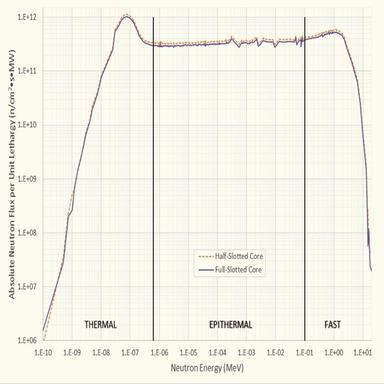
Comparison of Peak Neutron Flux Spectral Distribution between Half- and Full-Slotted Cores (300 K).